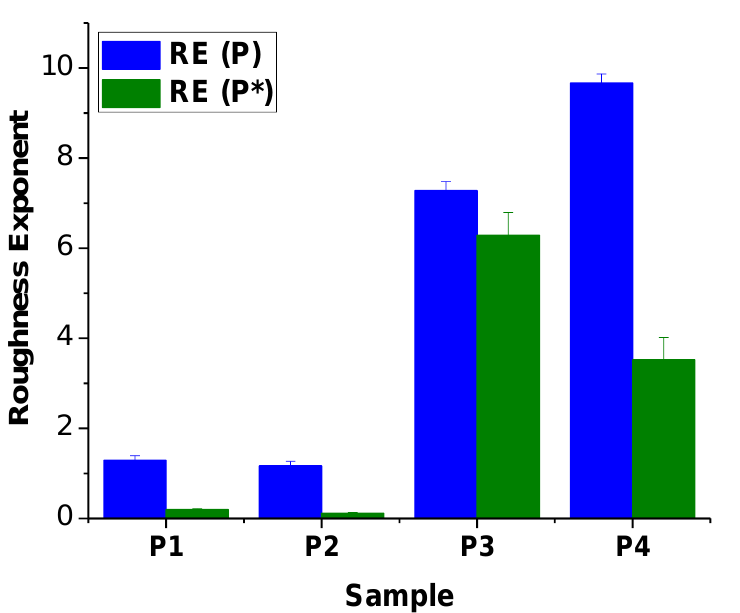
Figure 3. Representative 3D AFM images of the ( a – d ) untreated and ( e – h ) treated thin films acquired on squares of 1000 × 1000 nm and ( c ) the graphical representation of their roughness exponent (RE (P): roughness exponent of the untreated samples; RE (P*): roughness exponent of the treated sam- ples).